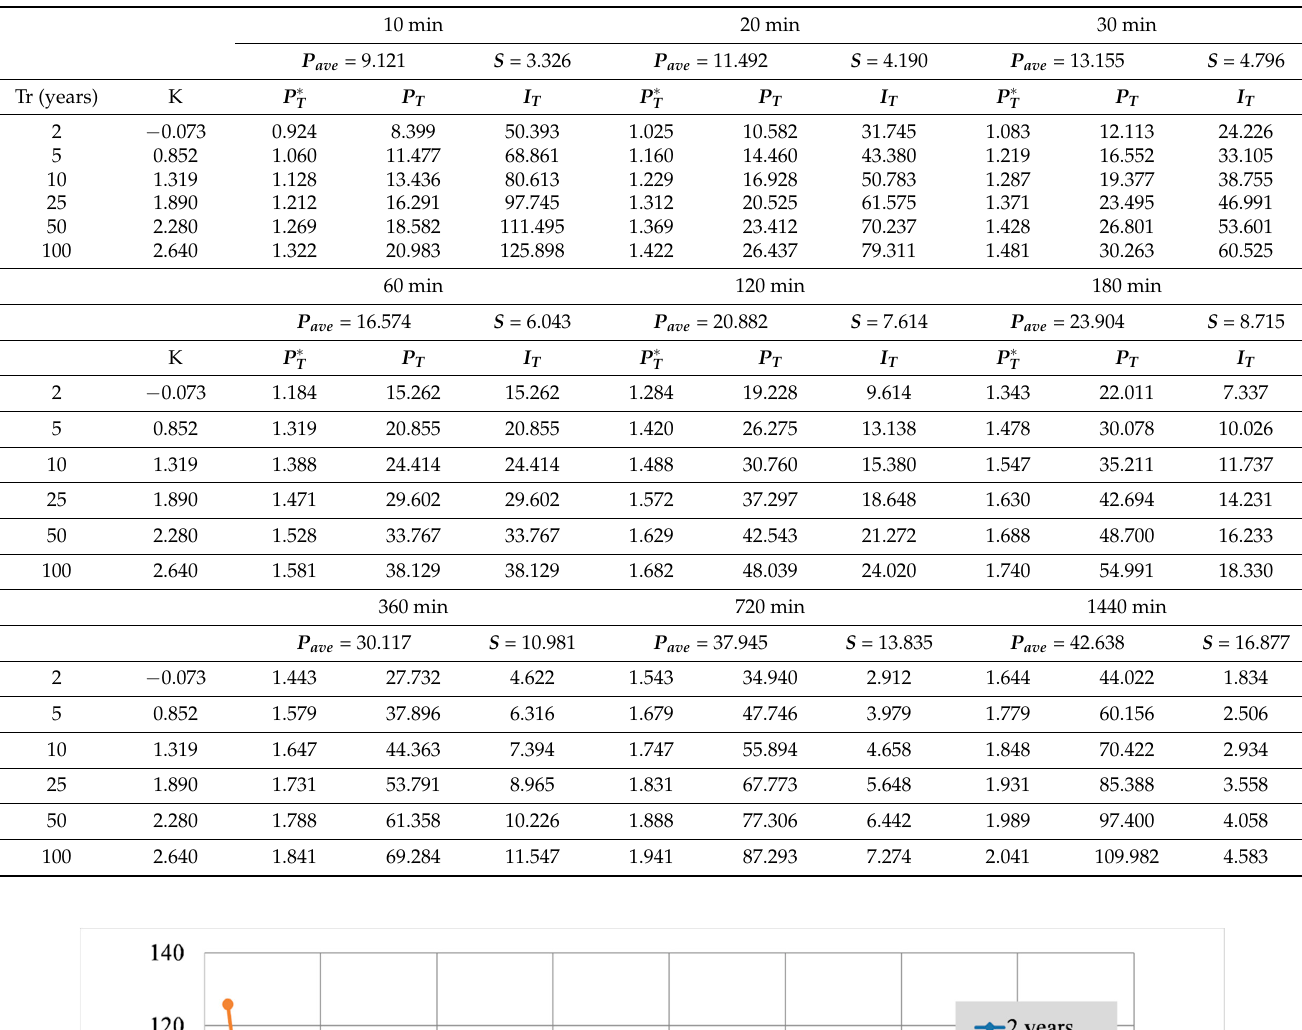
Table 3. Rainfall intensities calculated using the LPT III method for various standard time scales and return periods. 10 min 20 min 30 min P ave = 9.121